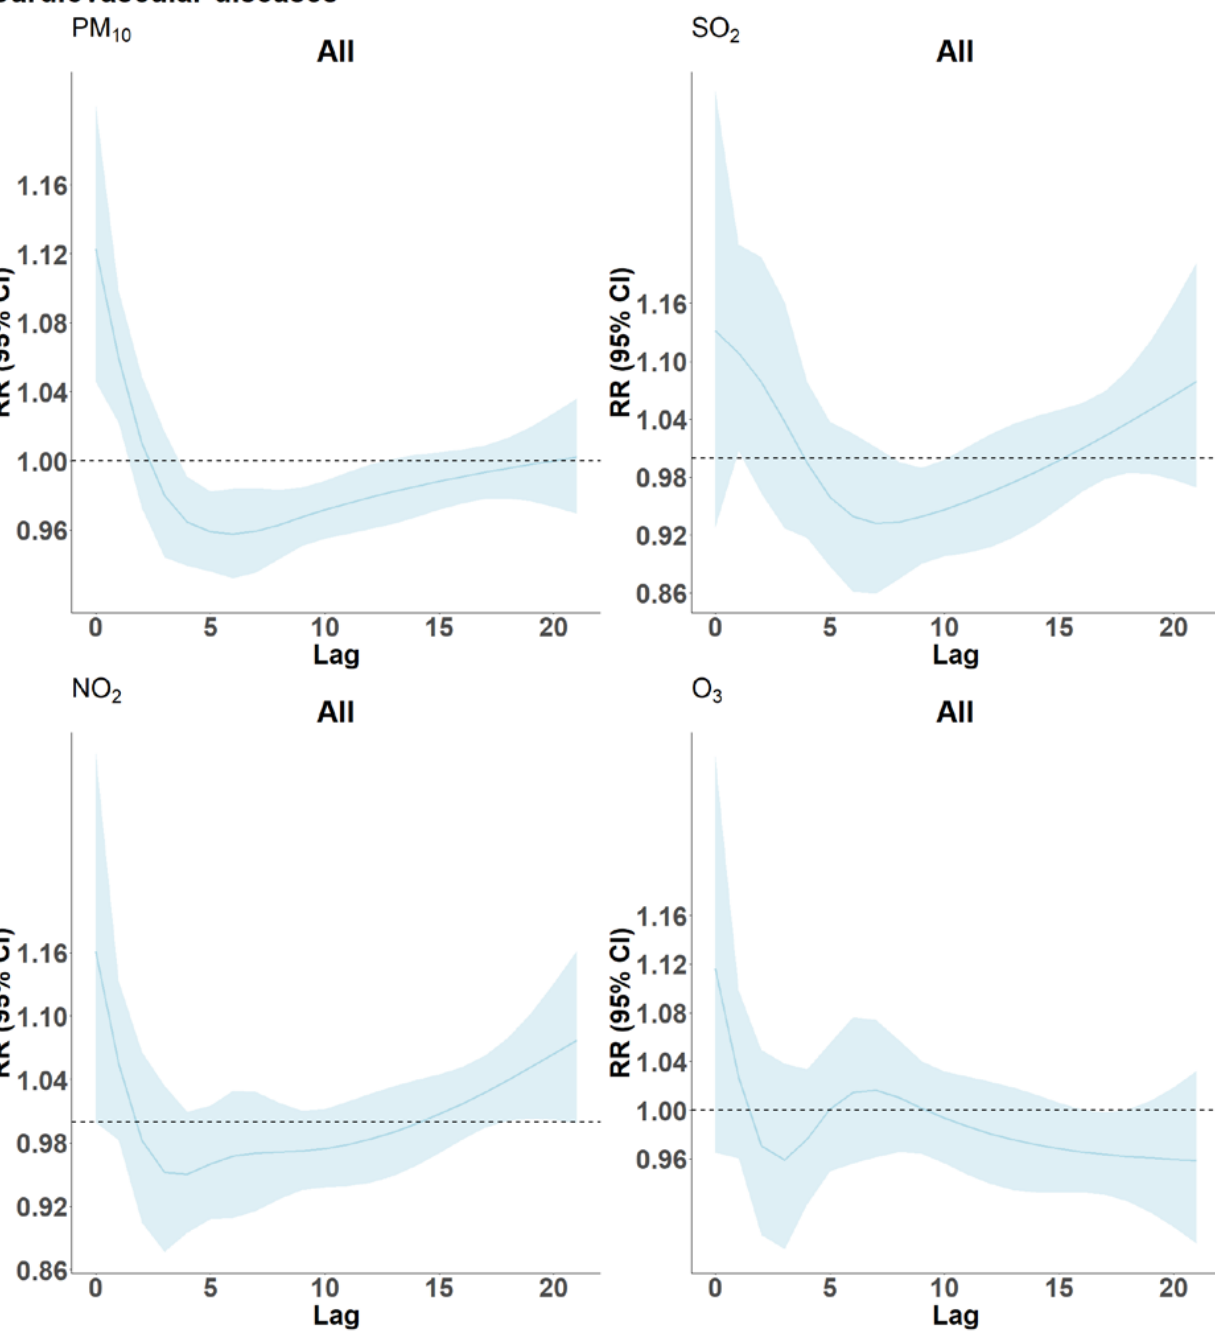
Figure 4. Lag structure (0–21) of the estimated effects of a 10 µg/m 3 increase in PM 10 , NO 2 , SO 2 and O 3 concentrations on cardiovascular disease mortality in Cape Town, South Africa, 2006–2015. The blue curve gives the RR-estimates and the light blue band their 95%-confidence intervals.